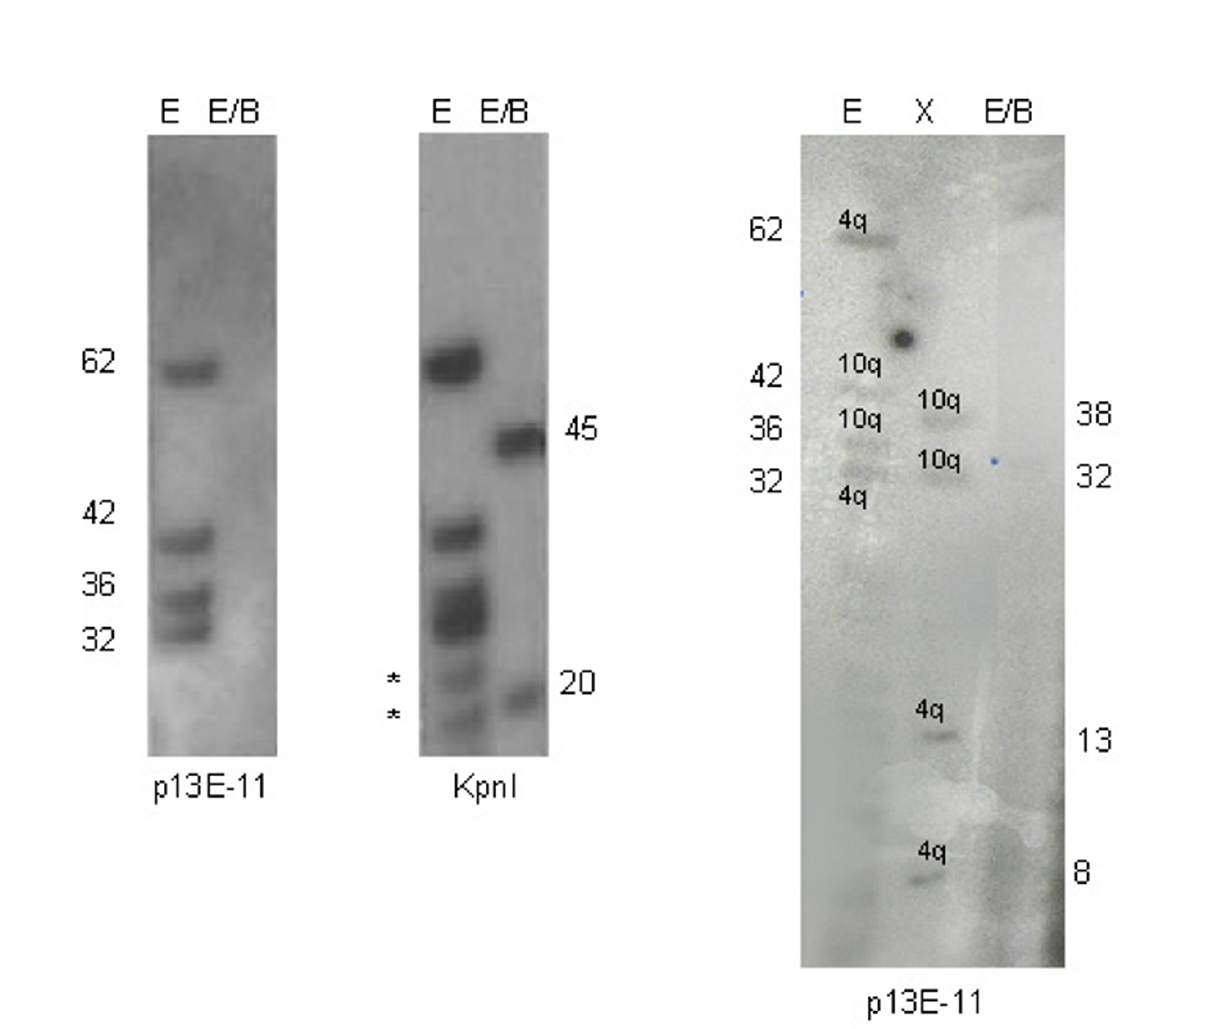
Nullisomic pattern . The patient shows four EcoRI bands after p13E-11 hybridization and none after double digestion with EcoRI/BlnI (nulisomic pattern). After hybridization with KpnI probe two BlnI resistant band are visible (45 and 20 kb): we can not guess the chromosomal origin of these alleles. To resolve the structure of the alleles we digested the sample with XapI enzyme which cuts the 4q-type repeats only (see Methods). After hybridization with p13E-11 we observed 4 XapI-resistant bands (38, 32, 13 and 8 kb): the 38 and 32 kb bands correspond to the EcoRI fragments of 42 and 36 kb fragments (XapI frag- ments are 4 kb smaller than EcoRI fragments). On the contrary the 13 and 8 kb fragments are stretches of the hybrid 4q alleles: the 62 kb EcoRI allele is composed by a BlnI-sensitive fragment (XapI-resistant) of 13 kb and a BlnI-resistant fragment of 45 kb (13+45 = 58 kb). The 32 kb EcoRI allele is composed by a BlnI-sensitive fragment (XapI-resistant) of 8 kb and a BlnI-resistant fragment of 20 kb (8+20 = 28 kb). The 4q variant alleles are represented in figure 5 (n.15 and 16). The FSHD 4q allele of 32 kb segregated also in other affected members of the family and its origin was confirmed by D4S139 probe (data not shown). * aspecific